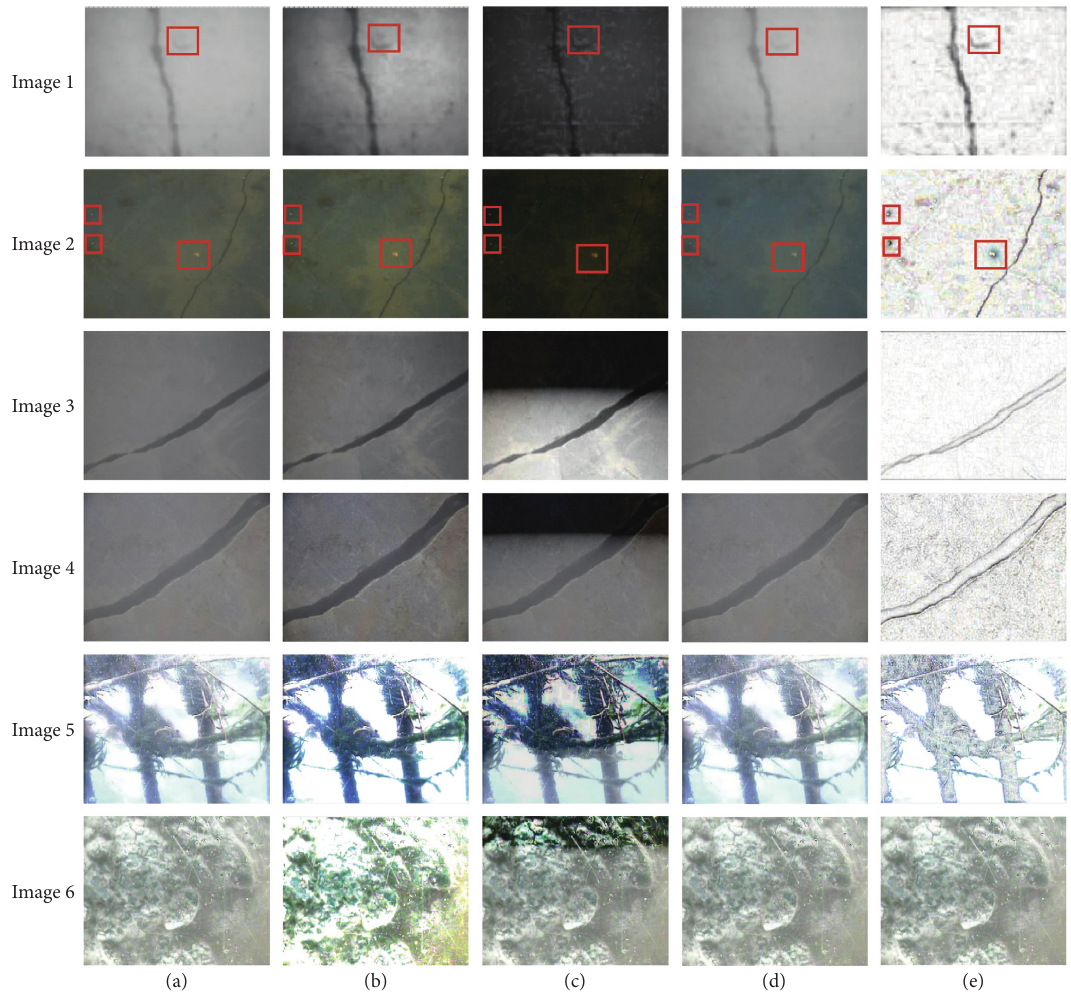
Figure 6: (a) Original image. Defogged images obtained using techniques of: (b) D algorithm [22], (c) Tarel algorithm [21], (d) Joost algorithm [15], and (e) DR